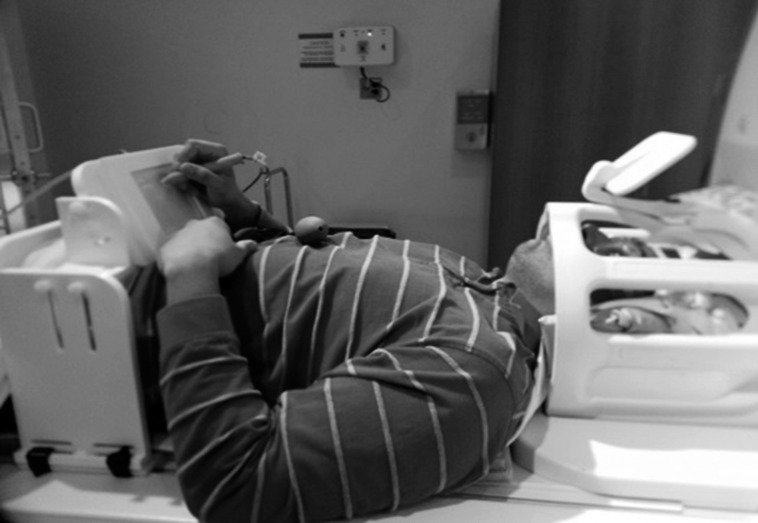
The fMRI-compatible tablet mounted for use by a subject. An angled mirror mounted on the head coil was used to view visual stimuli on a rear projection screen (not shown).